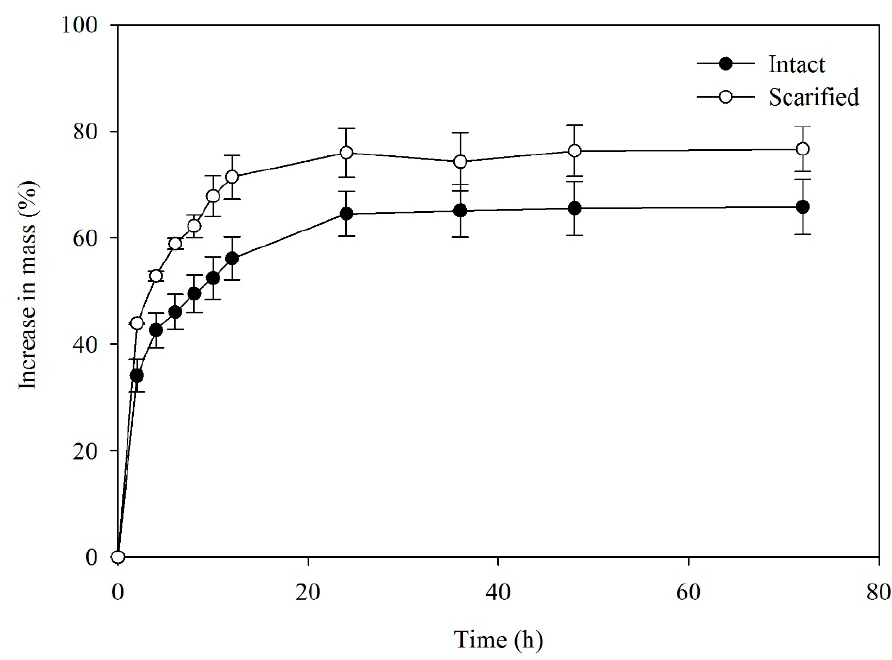
Figure 1. Imbibition curves for intact and scarified Sorbus alnifolia (Siebold & Zucc.) K.Koch seeds. Error bars are mean ± se.